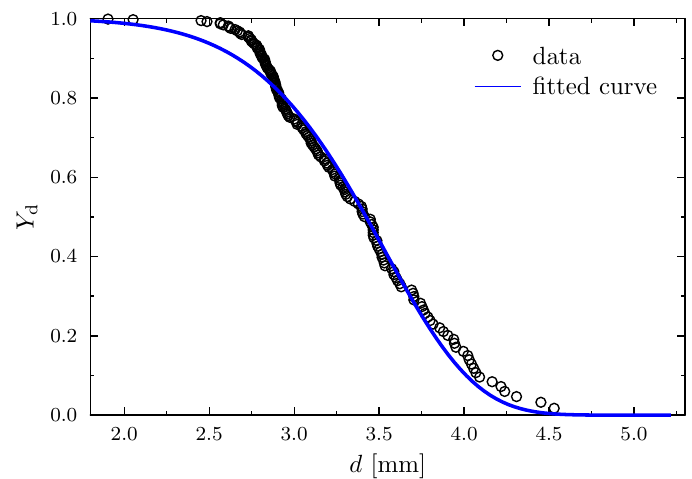
Figure 3. Experimental data for pellets TM0 and fitted Rosin–Rammler distribution curve (Equation